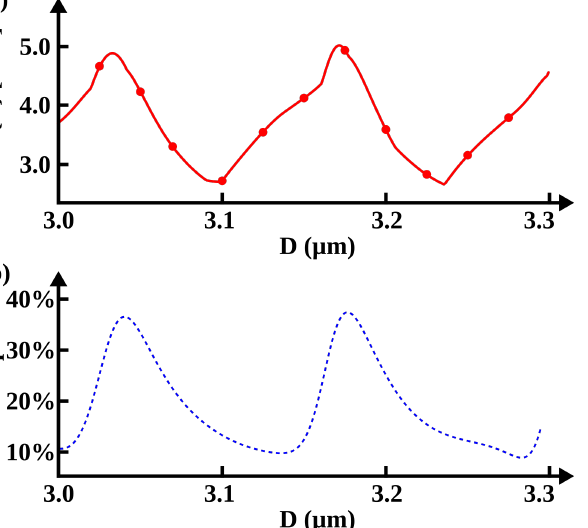
Figure 3. Influence of the microsphere diameter ( a ) on the peak amplitude of the real part of the electric field along the microsphere rim and ( b ) on the transmitted power. λ 0 = 600 nm, θ = 1 rad, ψ = 0 rad, n s =